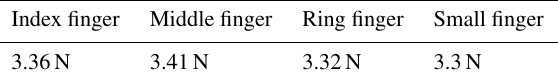
Table 4. The required tension force (in N) for each finger.